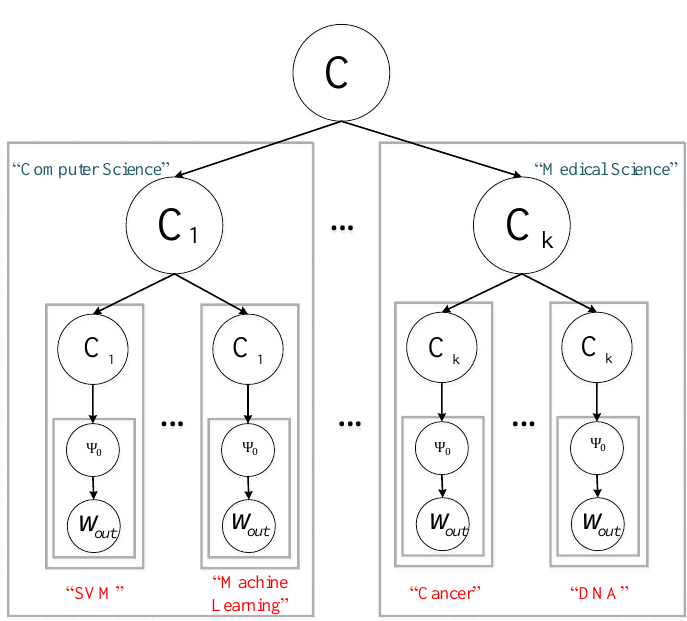
Figure 13. Hierarchical classification